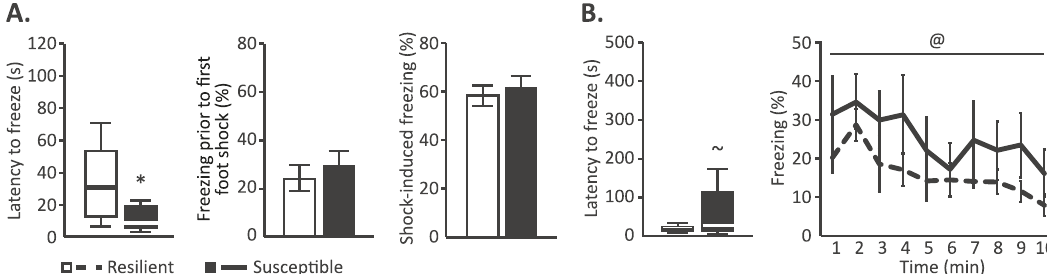
Fig. 3 Behavioral freezing in susceptible and resilient mice (cohort 4). Behavioral assessment of cohort 4 con fi rmed a shorter latency to freeze in susceptible animals in the trigger context ( A ), and revealed a trend towards a longer latency to freeze upon re-exposure to this context compared to resilient animals ( B ), with no differences in overall freezing levels or their reduction across prolonged exposure between these groups. Behavioral results on PTSD-like symptoms for this cohort are depicted in Figure S12. * p < 0.05, ~ p = 0.066, effect of PTSD-like phenotype; @ p < 0.05, effect of